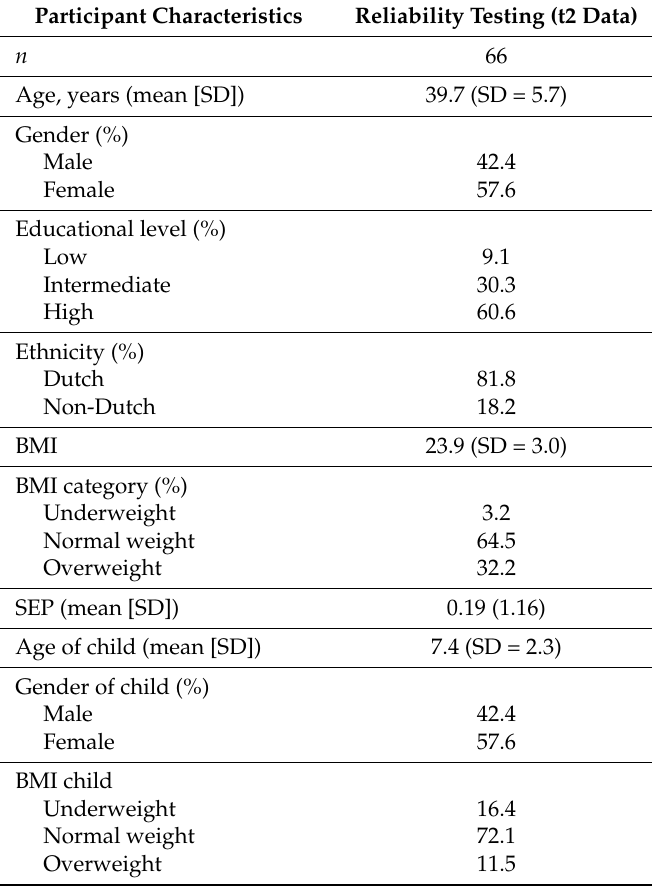
Table 1. Descriptive statistics of participants in